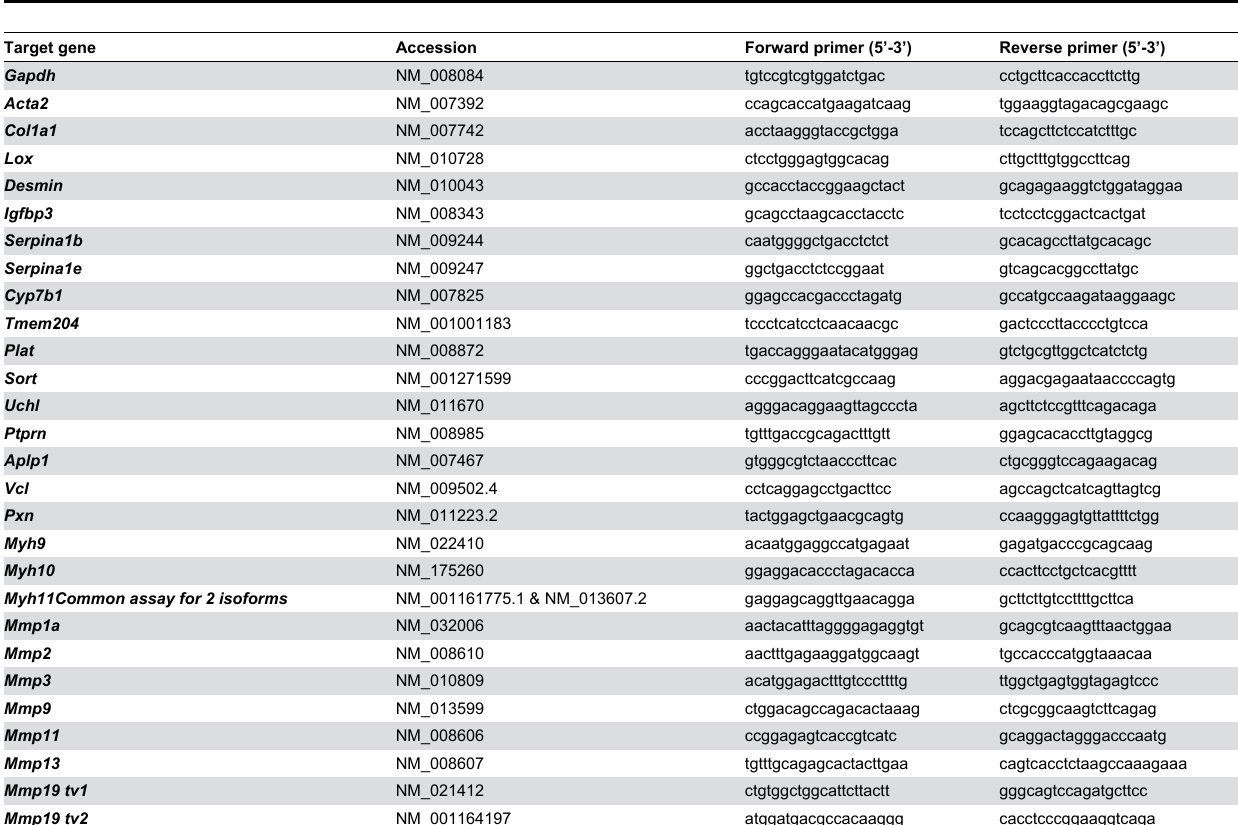
Table 1. Overview of the primer combinations for the different